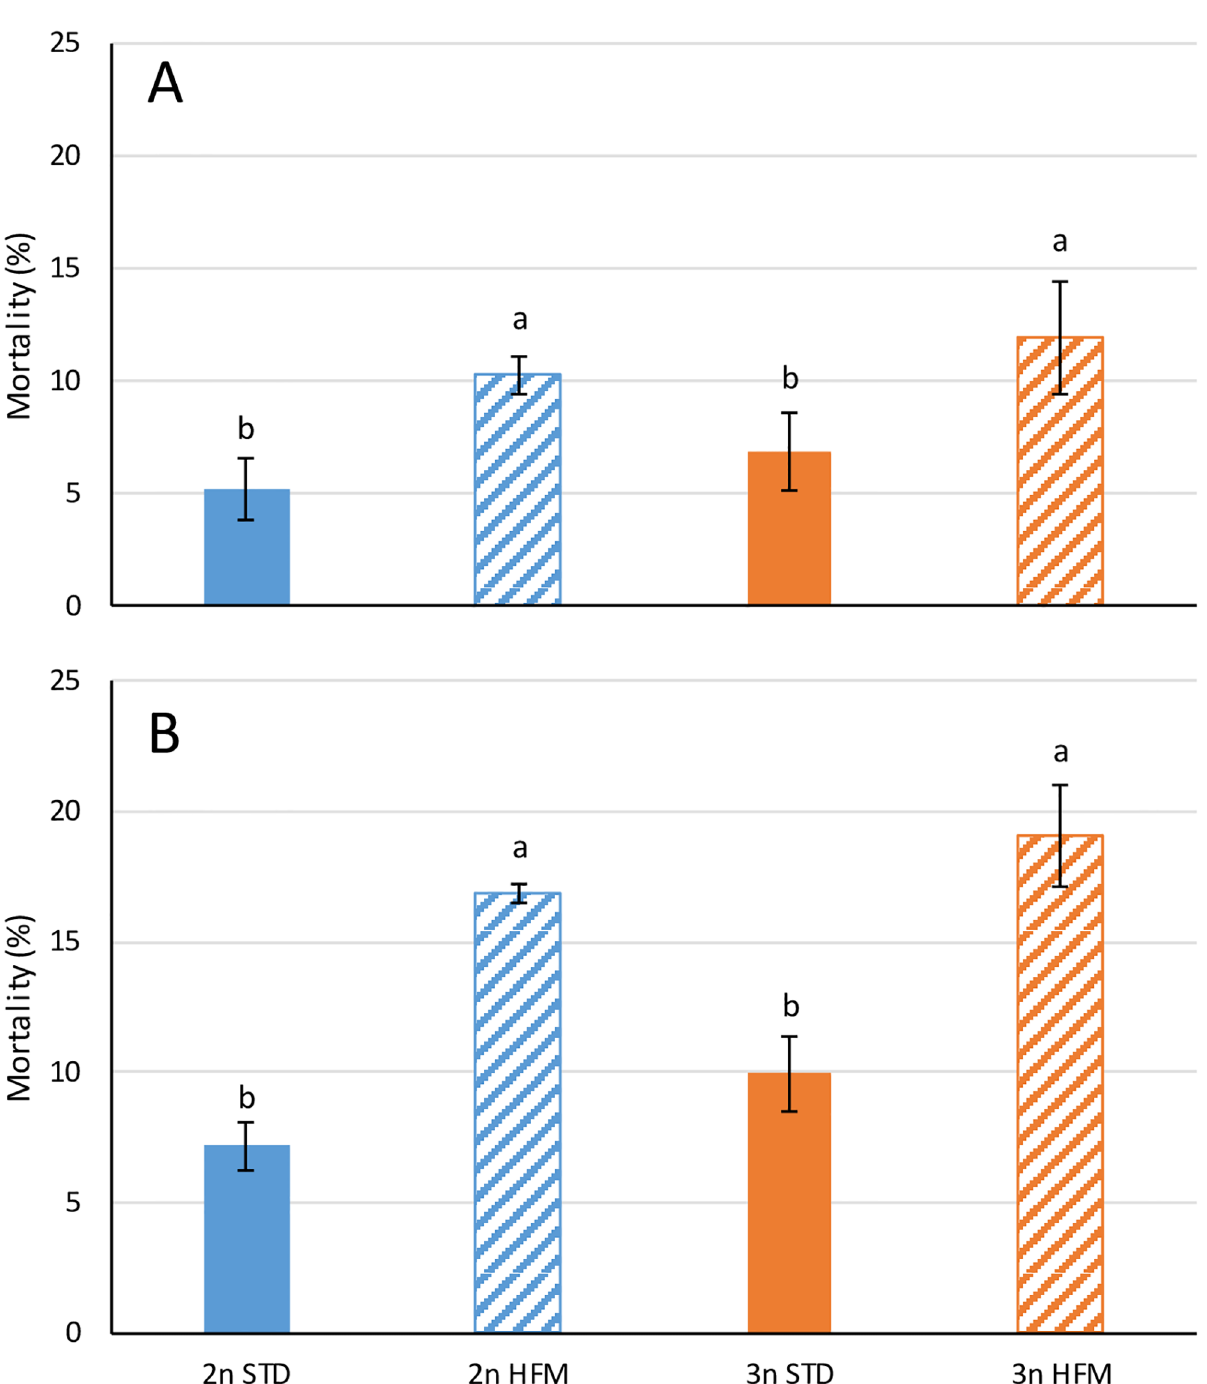
Fig 3. Fish mortality. Percentage of dead fish recorded in diploid (2n) and triploid (3n) salmon fed fish meal (STD) and hydrolyzed fish protein (HFM) diets over (A) the initial period (0–885 ddPSF) and (B) the whole experiment (0–2745 ddPSF). Different letters denote significant differences (P < 0.05). Data are presented as mean ± SEM (n =